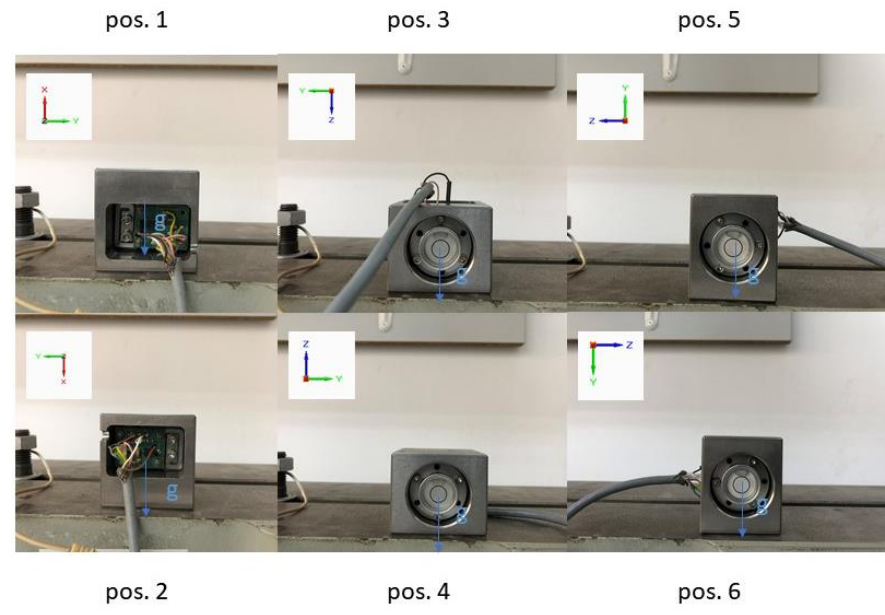
Figure 6. Six orientations of the sensor during calibration.